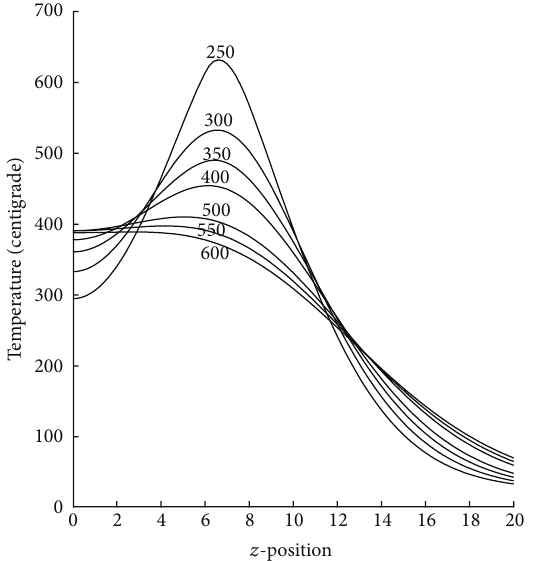
Figure 3: Temperature profiles on 𝑥 = 2.5 𝜇 m, 𝑦 = 0 as a function of 𝑧 at times 250, 300, 350, 400, 500, 550, and 600 𝜇 s.